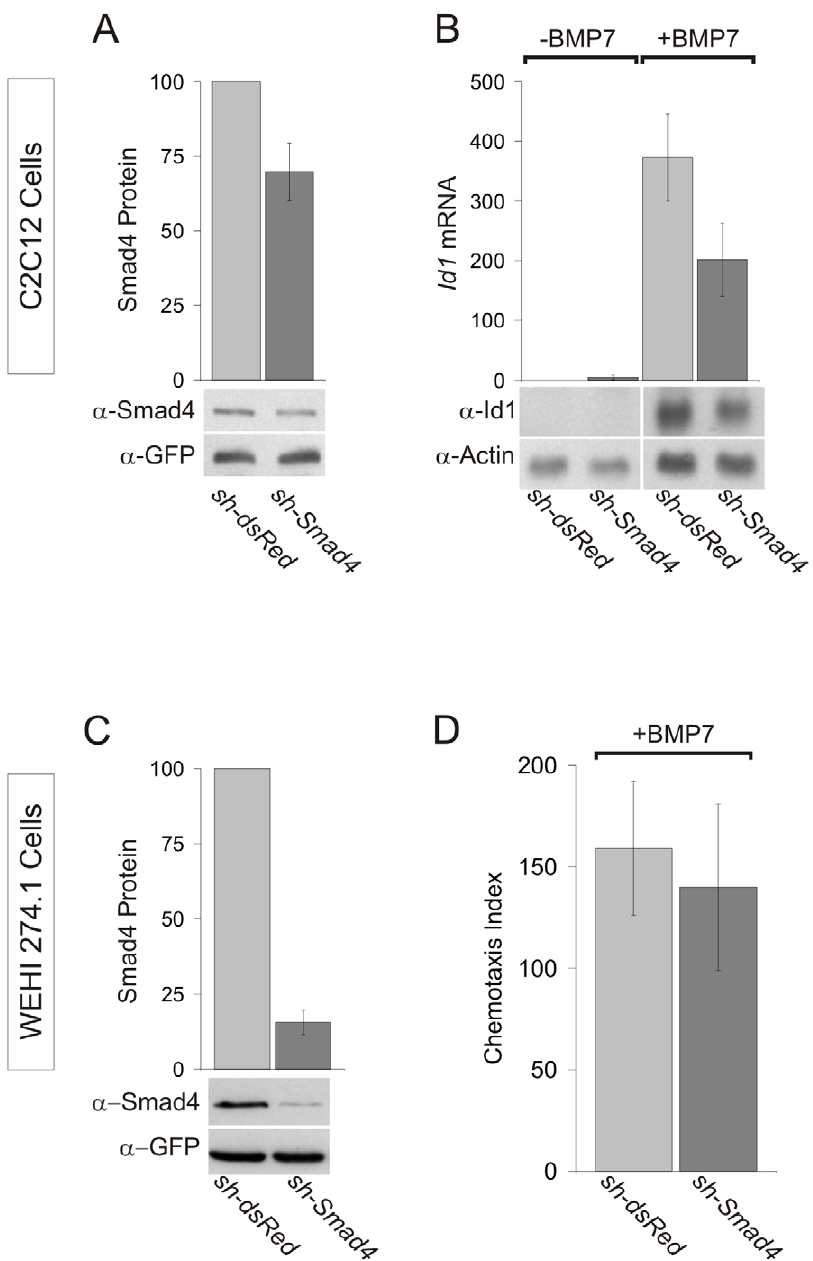
Figure 6. Knockdown of Smad4 inhibits BMP7-evoked Id1 induction but not BMP7-evoked chemotaxis. A: Western blot analysis of lysates of dsRed D C2C12 and Smad4 D C2C12 cells, probed for expression of Smad4 and GFP (loading control) and showing 30% knockdown of endogenous Smad4 (mean + / 2 SEM, n=3). B: Northern analysis of mouse Id1 expression in control and 150 ng/ml BMP7-stimulated dsRed D C2C12 and Smad4 D C2C12 cells ( Actin expression used as loading control). Smad4 D C2C12 cells show a 46% decrease in BMP7-evoked Id1 induction (mean + / 2 SEM, n=4). C: Western blots of lysates from dsRed D WEHI and Smad4 D WEHI cells, probed for expression of Smad4 and GFP (loading control), demonstrate efficient knockdown of endogenous Smad4 by sh-Smad4 (84% reduction, mean + / 2 SEM, n=3) in WEHI 274.1 cells. DD: dsRed D WEHI